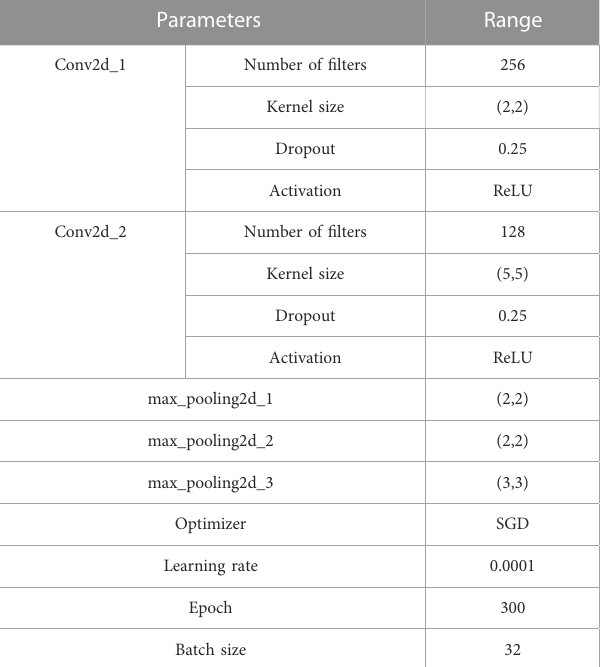
TABLE 2 The values of parameters used in our